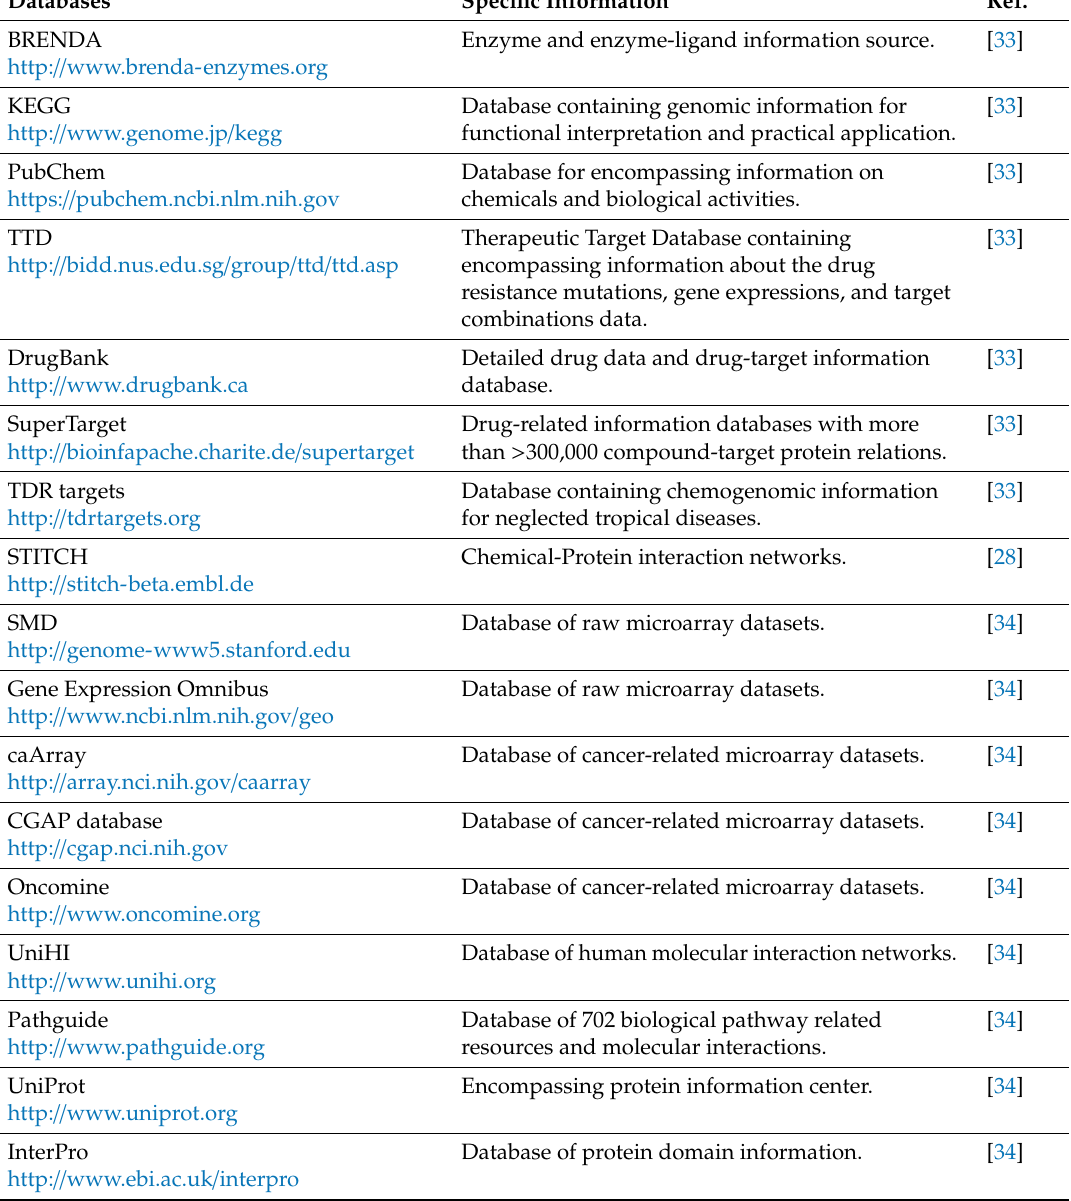
Table 1. Databases used for target